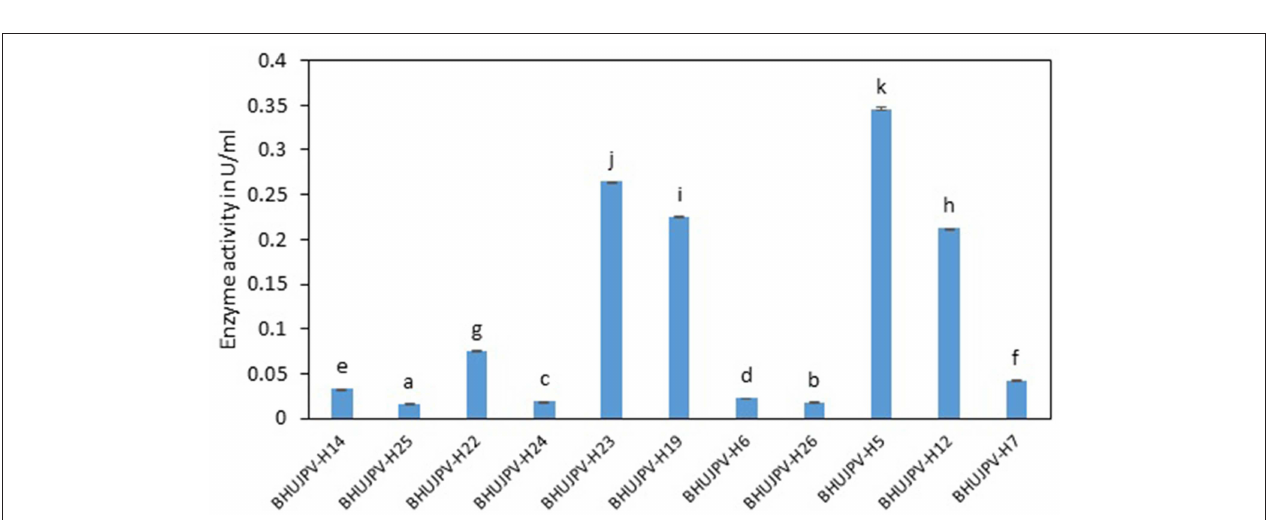
FIGURE 2 | Endoglucanase activity of the isolated bacterial strains at 72h of enzyme harvest. Values are the mean ± SE (standard error). Mean values in each bar with the same alphabet superscript(s) do not differ significantly, but different alphabet superscript is showed significantly different between each treatment by Duncan post hoc test ( p ≤